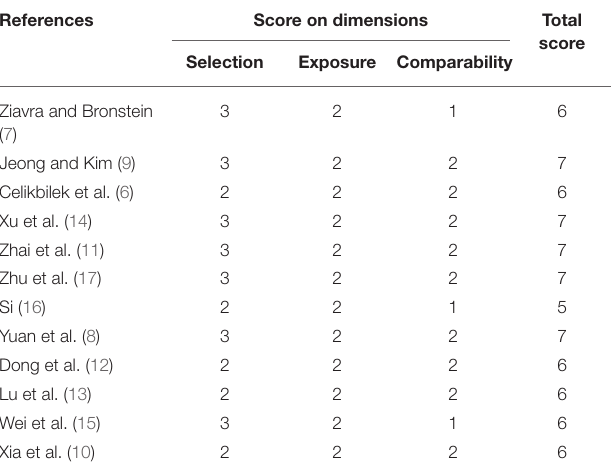
TABLE 2 | Quality assessment.